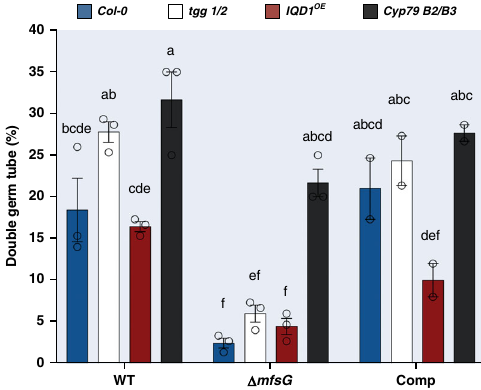
Fig. 5 Germination test of B. cinerea Δ mfsG mutants and complemented mutants. The number of double germ tubes in germinating conidia was evaluated by bright- fi eld microscopy 24 h after inoculation of Arabidopsis wild type (WT; Col-0 ), IQD1 OE and tgg1/2 with B. cinerea WT, knockout mutants ( Δ mfsG ) and complemented mutants (Comp). Data are displayed as mean values (± SE). Different letters above the columns indicate signi fi cant difference at P < 0.05, as determined by Tukey – Kramer HSD test, n > 20. Source data are provided as a Source Data fi and 4). We found a high correlation between linear mycelium